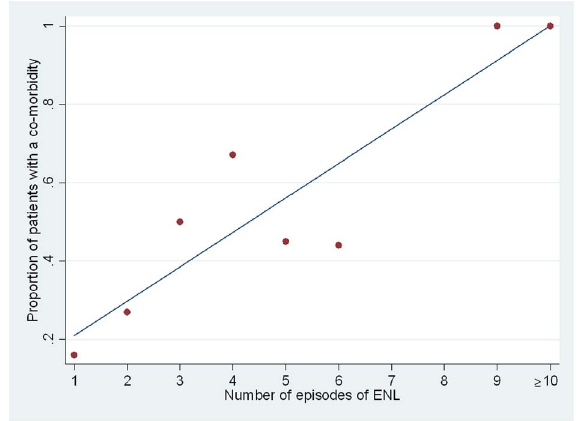
Figure 4. The proportion of individuals with a co-morbidity and the number of episodes of